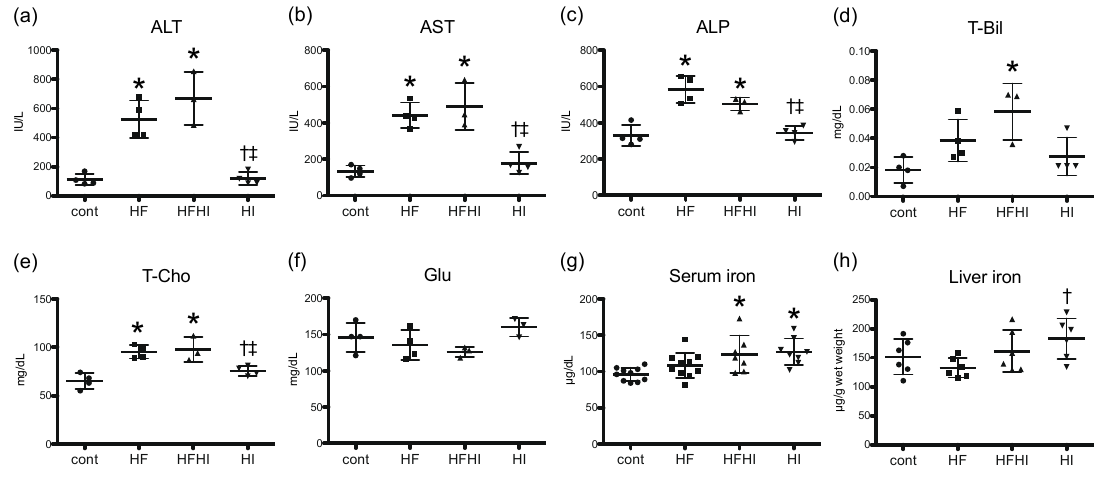
Figure 2. Blood biochemical data of ( a ) alanine aminotransferase (ALT); ( b ) aspartate aminotransferase (AST); ( c ) alkaline phosphatase (ALP); ( d ) total bilirubin; ( e ) total cholesterol; ( f ) glucose; ( g ) serum iron and ( h ) liver iron ( a – f : n = 4 or 3, g : n = 7 to 10, h : n = 6 in each group). Data are expressed as mean ± standard deviation (SD). * p < 0.05 vs. control, † vs. HF, ‡ vs. HFHI, by Tukey-Kramer’s multiple comparison.